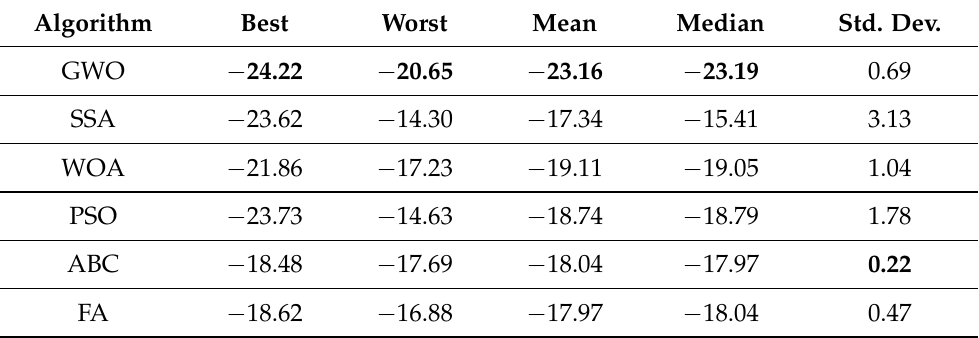
Table 3. Comparative results (pSLL values) for the position-phase synthesis of a 50-element linear array (best values are indicated in bold, all values are expressed in